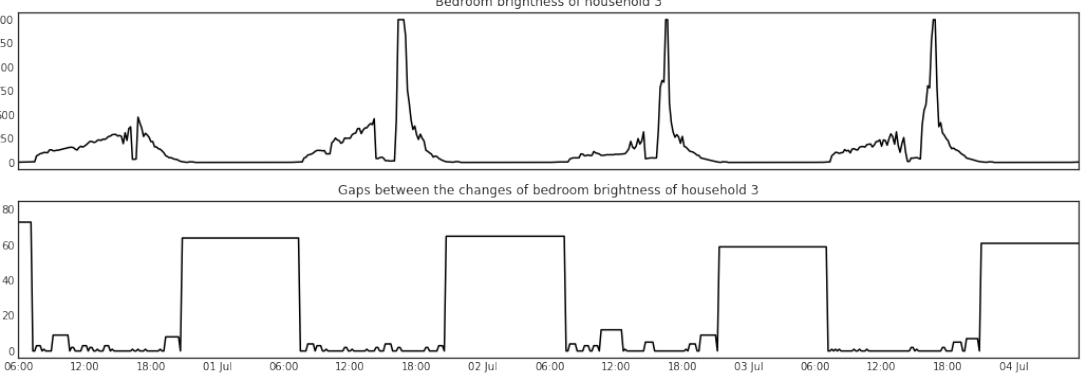
Figure 8. Gaps between change points in the brightness readings from the sensor box in the bedroom of Household